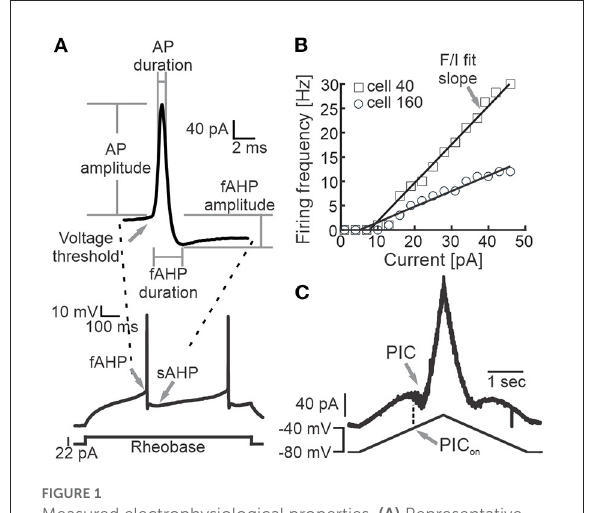
FIGURE1 Measured electrophysiological properties. (A) Representative example of a recording of the membrane potential of a Shox2 neuron during the injection of a 1s long current step at rheobase (bottom) and magnification of the first action potential generated (top). Arrows point out the voltage threshold and fast and slow AHP. The AP and fAHP amplitude and duration measurement points are shown. (B) Action potential firing frequency in response to the injection of depolarizing currents in two representative Shox2 neurons (squares, cell #40; circles, cell #160). Lines represent the F/I fit slope (arrow). (C) Current response (upper trace) to slow depolarizing ramp injection. Arrows point out the presence of PIC and the corresponding voltage on the ramp to activate the PIC (PIC on